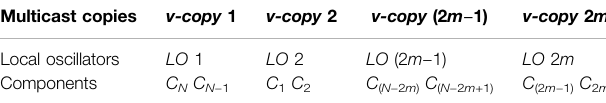
TABLE 1 | Relationship among multicast copies, local oscillators, and components.